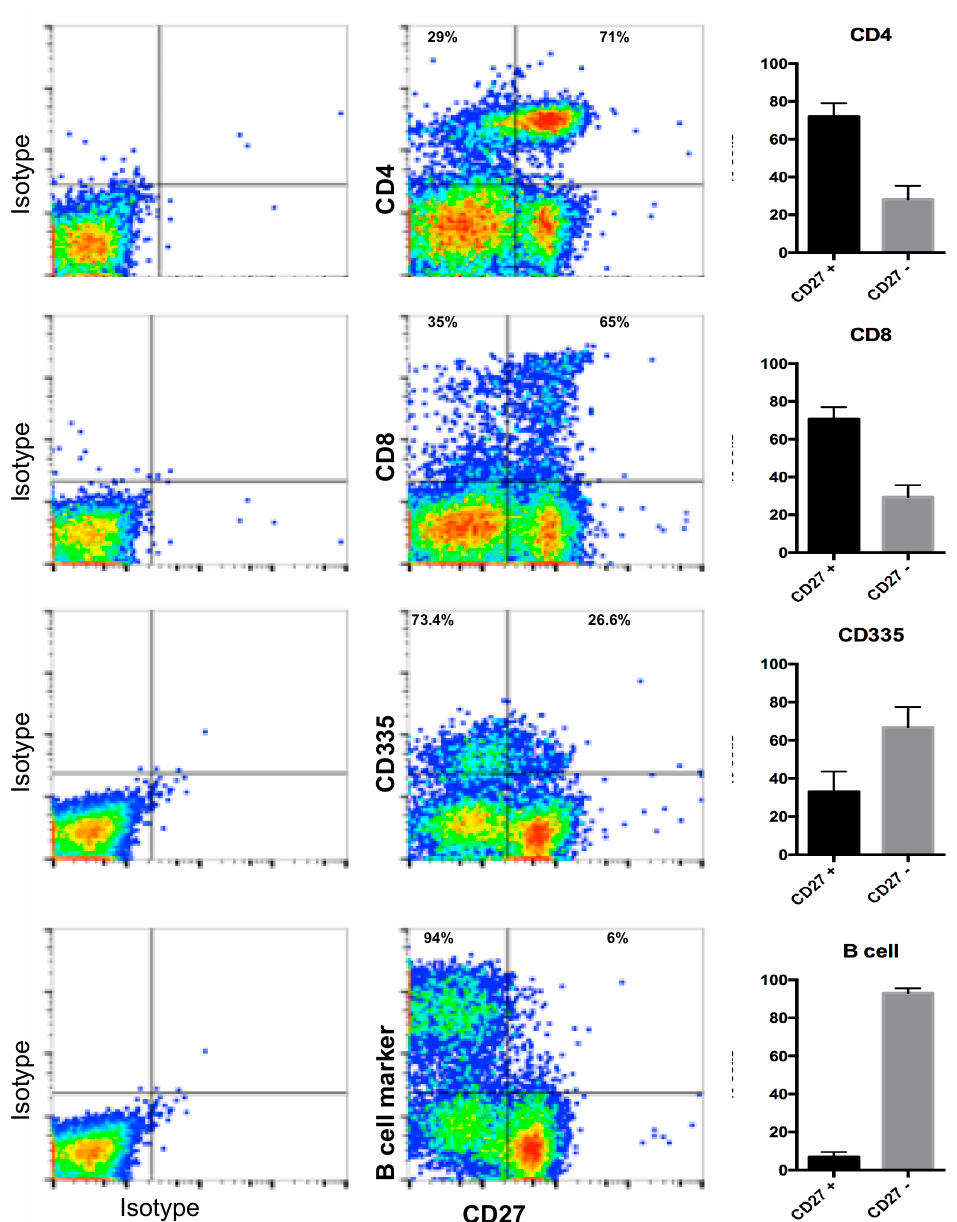
Figure 7. CD27 expression on ovine PBMC populations. Ovine PBMC, derived from n = 15 animals were costained for CD27 and CD4, CD8, CD335, or B cell markers. Gates were set using the corresponding isotype controls. Isotype control staining and representative dot plots for CD27 staining and CD4; CD8; CD335 or B cell marker are shown. Bar charts show the mean ( ± SD) percentage of CD27 + and CD27 - cells in the CD4 / CD8 / CD335 / B cell marker gates (upper quadrants) in donor sheep PBMC.